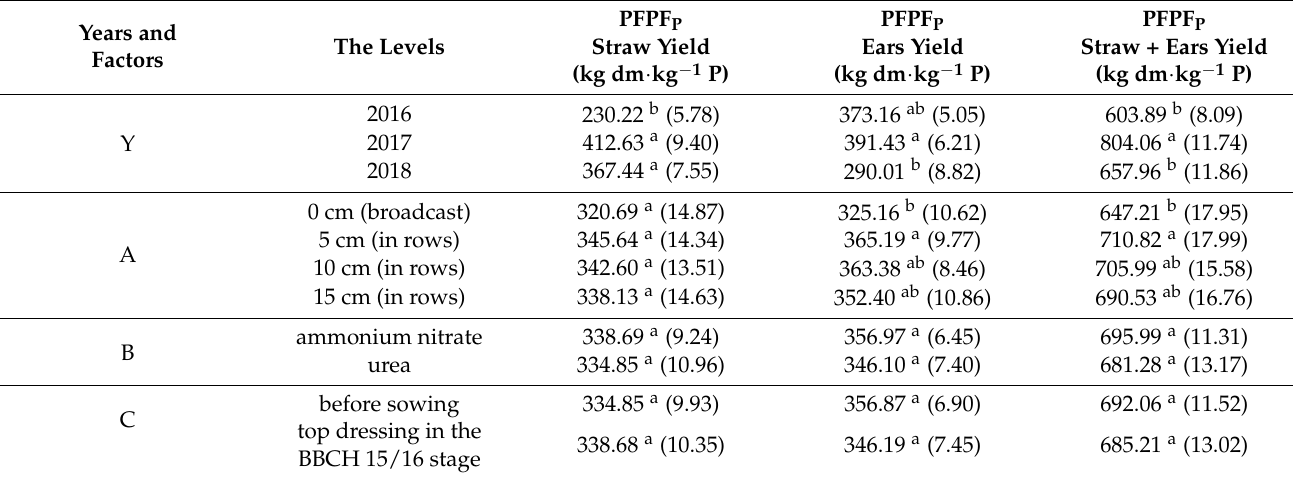
Values in columns marked with at least the same letter do not differ significantly at p ≤ 0.05. dm—dry matter. Standard errors are in